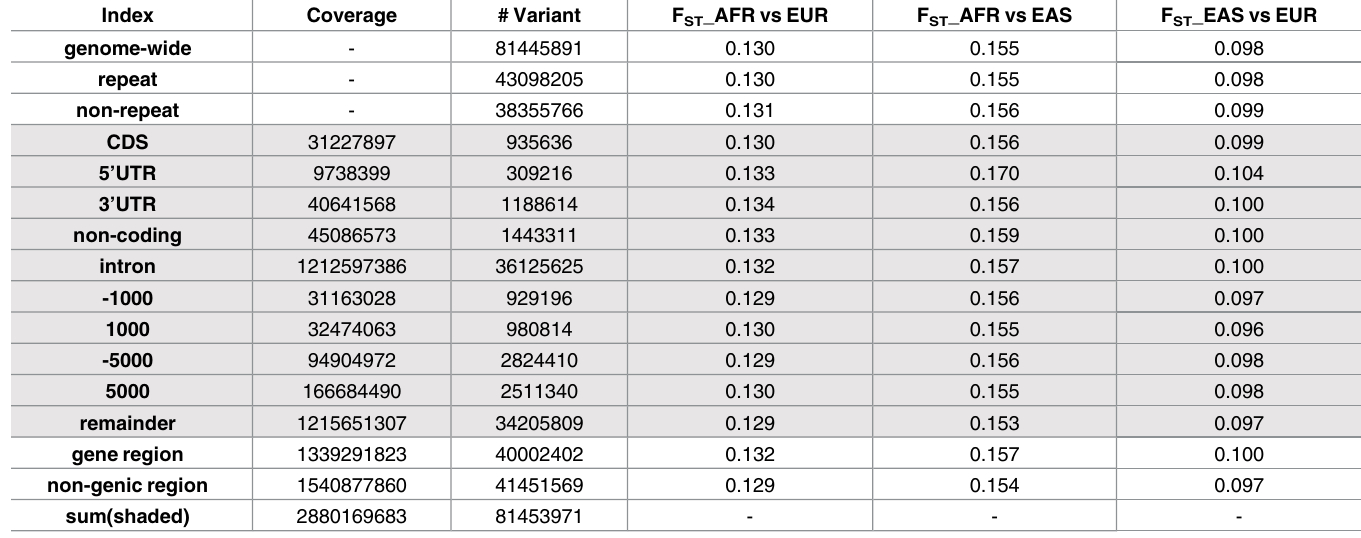
Table 1. Summaryof F ST estimates(ratios of averages)of the total target regions in the human